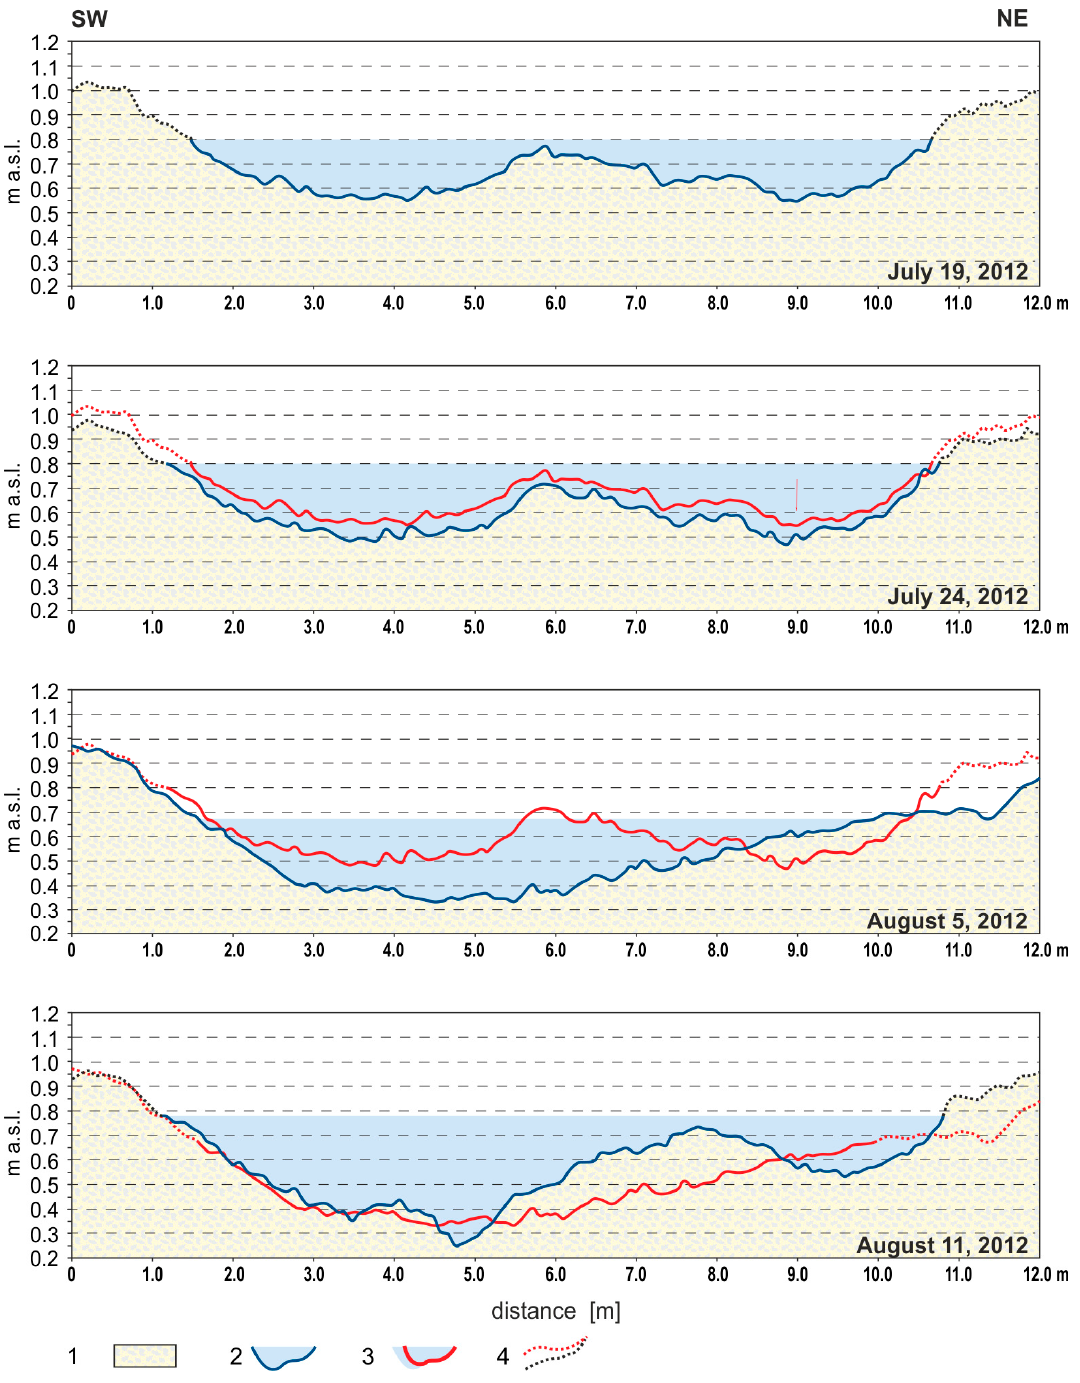
Figure 6. Changes in the channel bottom in XS II in 2012: 1. Bedrock, 2. Current stage, 3. Previous stage, 4. Dry streambank.